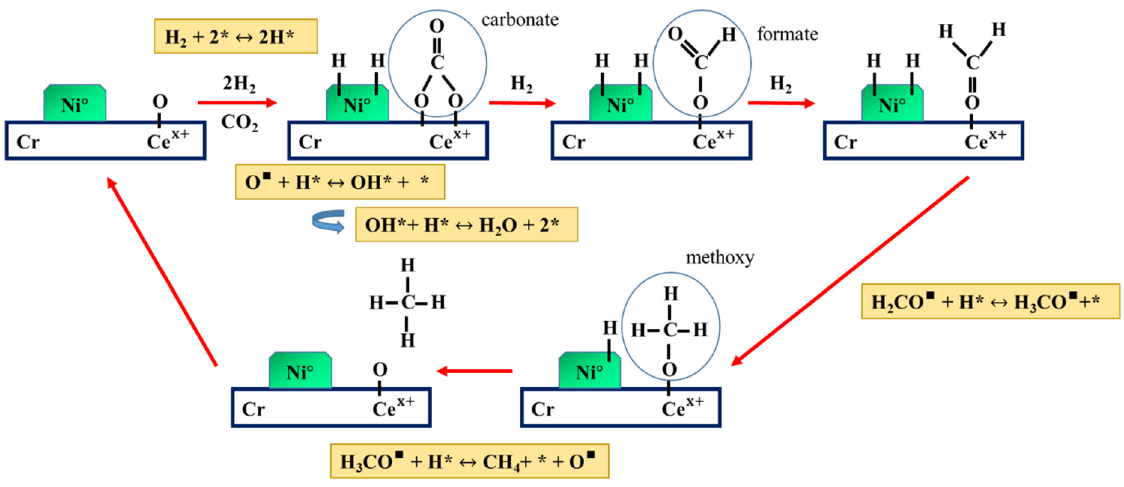
Figure 6. Mechanism proposed for CO 2 hydrogenation over the surface of Ni-CeO 2 /Cr 2 O 3.